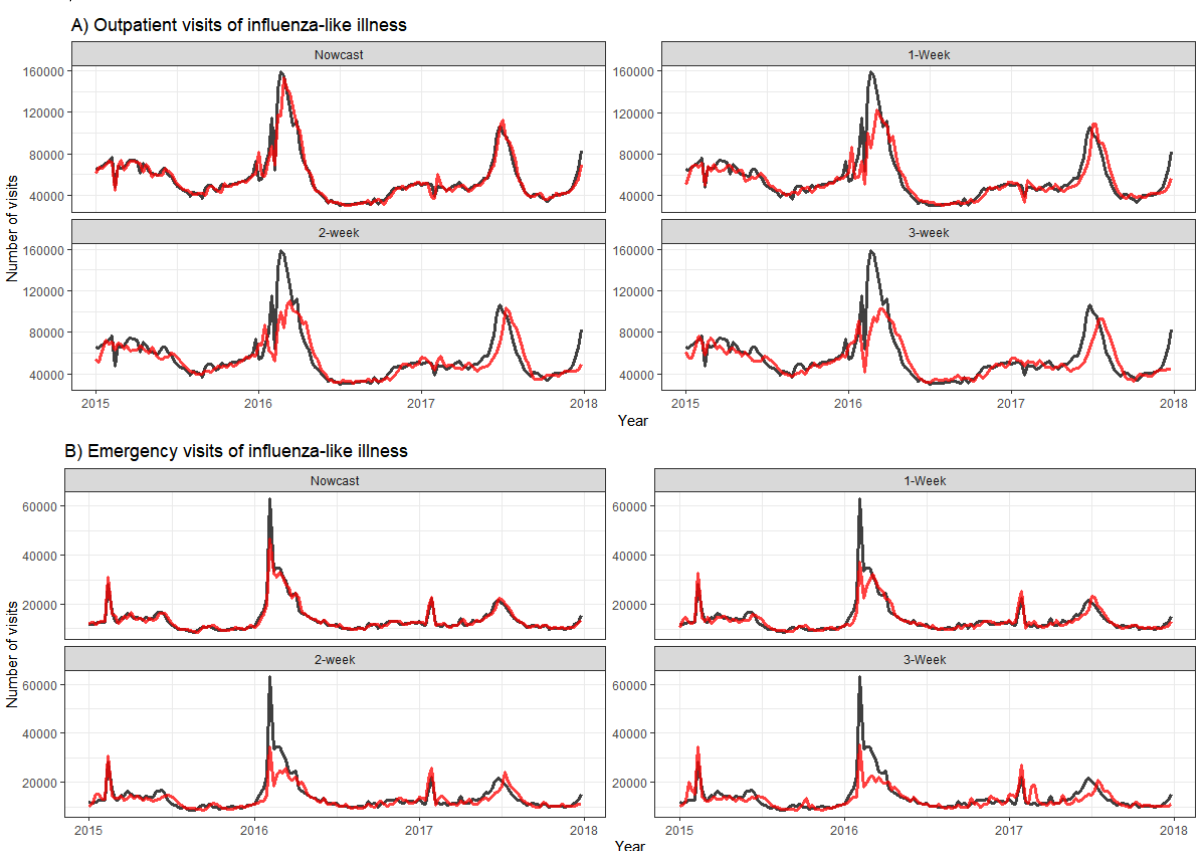
Figure 4. Forecasts using the ensemble model (red) and the observed (black) number for influenza-like illness visits in (A) outpatient and (B) emergency departments,